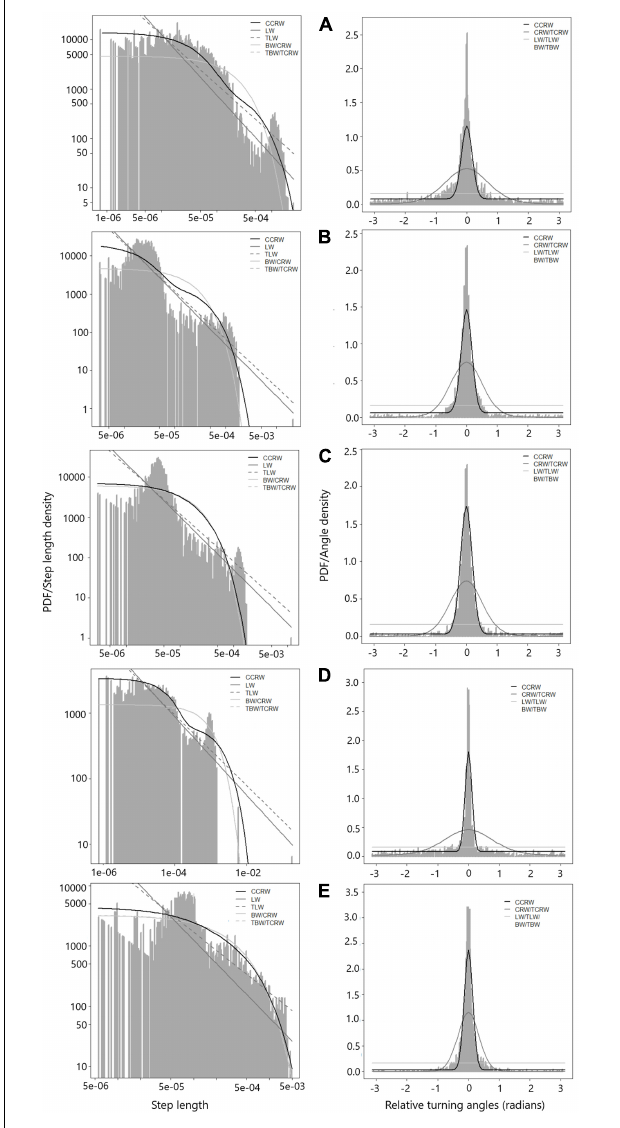
FIGURE 2 | Model fitting to data from trajectories. (A) diving; (B) hand net; (C) gareteo; (D) handlines; (E) longline. Left figure represents step length, right figure represents relative turning